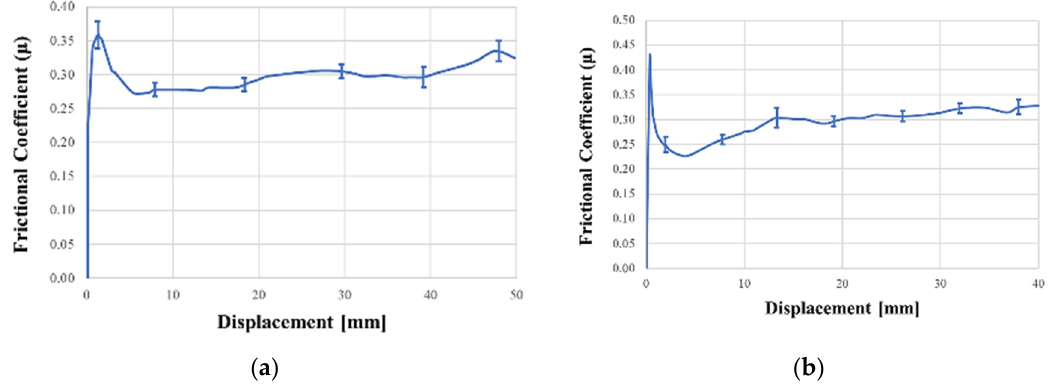
Figure 26. Average results of the tool-ply test: GF/PP ( a ) and CF/PA66 ( b ). Table 3. Static and Dynamic Frictional coefficients calculated for GF/PP and CF/PA66.